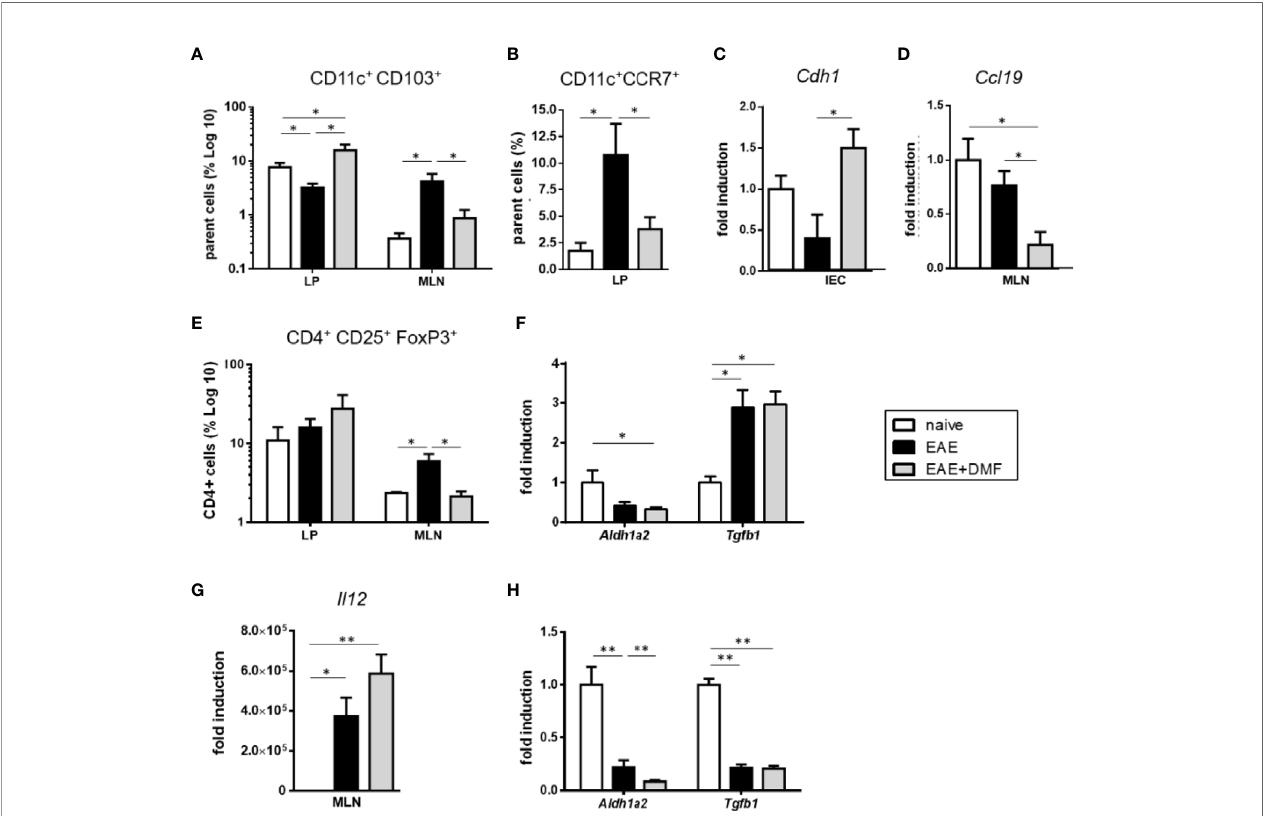
FIGURE 6 | DMF treatment likely affects both migration and differentiation of immune cells in the small intestine of EAE-affected mice. (A) CD11c+CD103+ cells are retained in LP of EAE-affected DMF-treated mice. FACS analysis of CD11c+CD103+ cells in the parent cell population (i.e. identi fi ed as non IEC by size and granularity) in ileum LP and MLN of naïve and EAE-affected mice, treated or not with DMF. (B) DMF treatment of EAE-affected mice decreases the percentage of migratory CD11c+CCR7+ cells in ileum LP. FACS analysis of CD11c+CCR7+ cells over parent cells (as above) in ileum LP of naïve and EAE-affected mice, treated or not with DMF. (C) The expression of the CD103 ligand, Cdh1 , is increased in IEC of EAE-affected DMF-treated mice. Cdh1 mRNA expression in IEC from naïve and EAE-affected mice treated or not with DMF. (D) The expression of the CCR7 ligand, Ccl19 , is decreased in IEC of EAE-affected DMF-treated mice. Ccl19 mRNA expression in IEC from naïve and EAE-affected mice treated or not with DMF. (E) The pattern of Treg cell frequencies of naïve and EAE-affected mice treated or not with DMF parallels that of CD11c+CD103+cells in MLN, but not in LP. FACS analysis of CD4+CD25+FoxP3+ cells, within the CD4+ cell population, in ileum LP and in MLN from naïve and EAE-affected mice, treated or not with DMF. (F) DMF treatment does not revert the EAE-induced decrease in Aldh1a2 or increase in Tgfb1 in MLN. Aldh1a2 and Tgfb1 mRNA expression in MLN cells from naïve and EAE-affected mice treated or not with DMF. (G) DMF treatment does not revert the increased Il12 expression induced by EAE in MLN. Il12 mRNA expression in MLN isolated from naïve and EAE-affected mice treated or not with DMF. (H) DMF treatment of EAE-affected mice further decreases Aldh1a2 expression in IEC but does not revert that of Tgfb1 . Aldh1a2 and Tgfb1 mRNA expression in IEC isolated from naïve and EAE-affected mice treated or not with DMF. Average clinical scores of mice at the time of the analysis: WT-EAE-affected mice: 3 ± 0.17; WT-EAE- affected mice treated with DMF: 2.75 ± 0.11. Real time PCR data are presented as fold induction of gene expression in cells from EAE-affected mice (treated or not with DMF) over cells from naïve mice. FACS and PCR results are shown as mean ± SEM of at least N = 3 experiments, with at least N = 5 mice per group per experiment. * P < 0.05 and ** P <